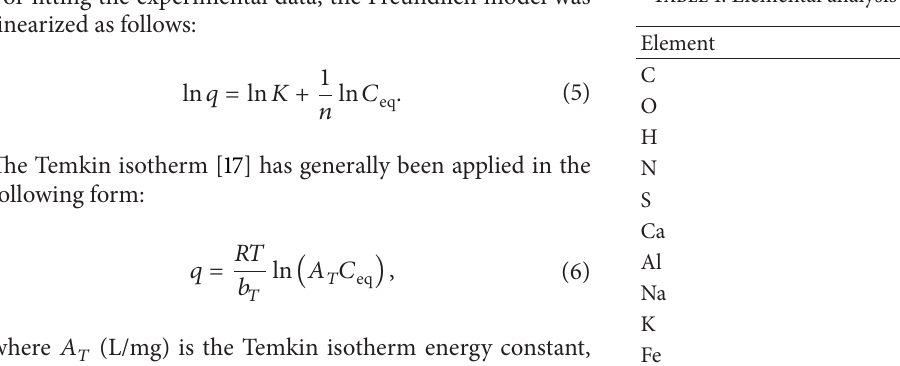
Table 1: Elemental analysis of biosorbent Ficus benghalensis L.